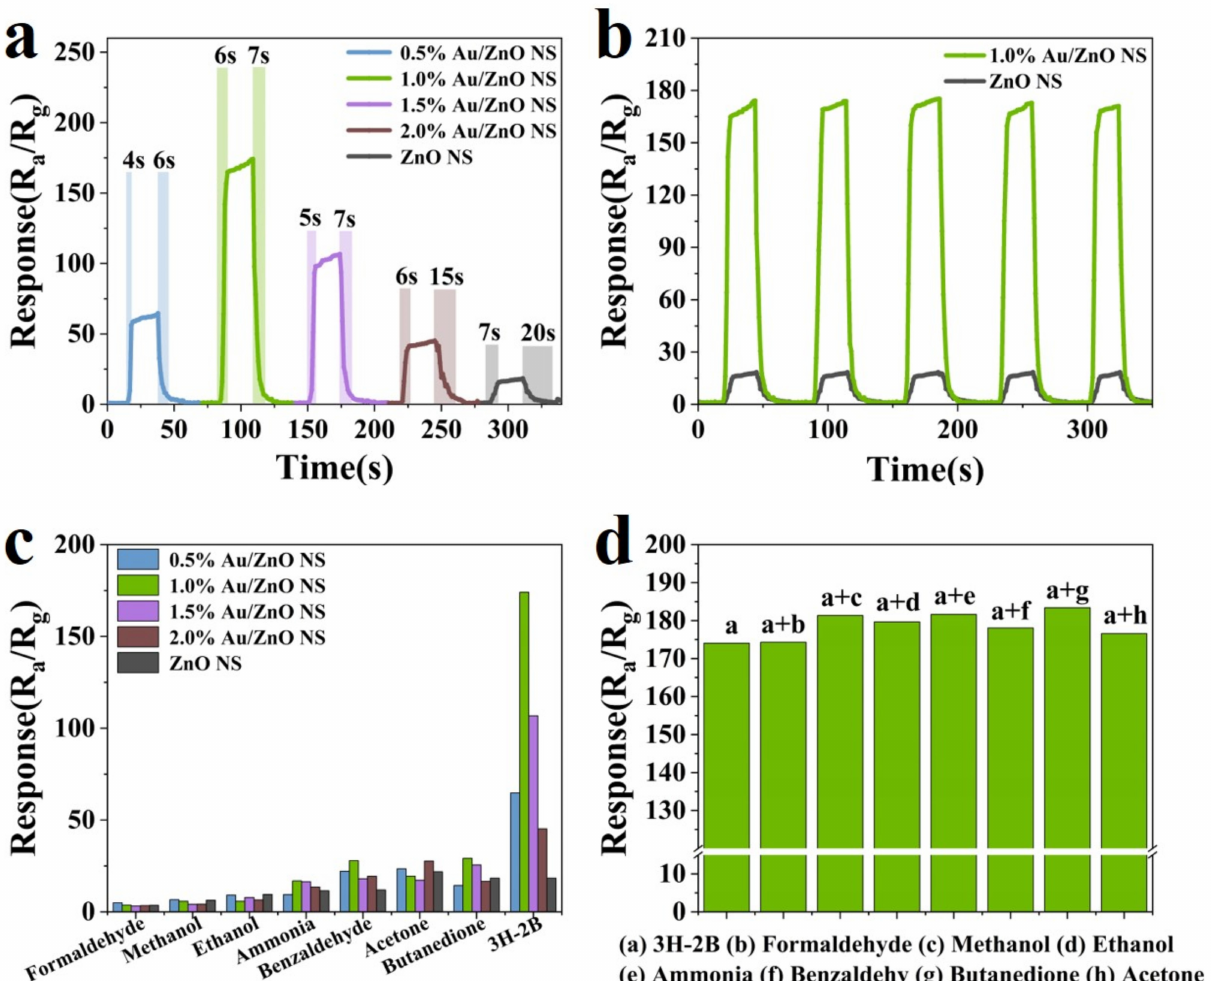
Figure 6. ( a ) The response/recovery time of 0.5% Au/ZnO NS, 1.0% Au/ZnO NS, 1.5% Au/ZnO NS, 2.0% Au/ZnO NS, and ZnO NS towards 25 ppm 3H-2B. ( b ) The repeatability of 1.0% Au/ZnO NS and ZnO NS to 3H-2B towards 25 ppm. ( c ) The selectivity of 0.5% Au/ZnO NS, 1.0% Au/ZnO NS, 1.5% Au/ZnO NS, 2.0% Au/ZnO NS, and ZnO NS towards 25 ppm interference gases and 3H-2B. ( d ) The discrimination test of 1.0% Au/ZnO NS sensors to the response of the mixed gas containing 25 ppm 3H-2B and other interference gases. All tests were operated at 230 ◦